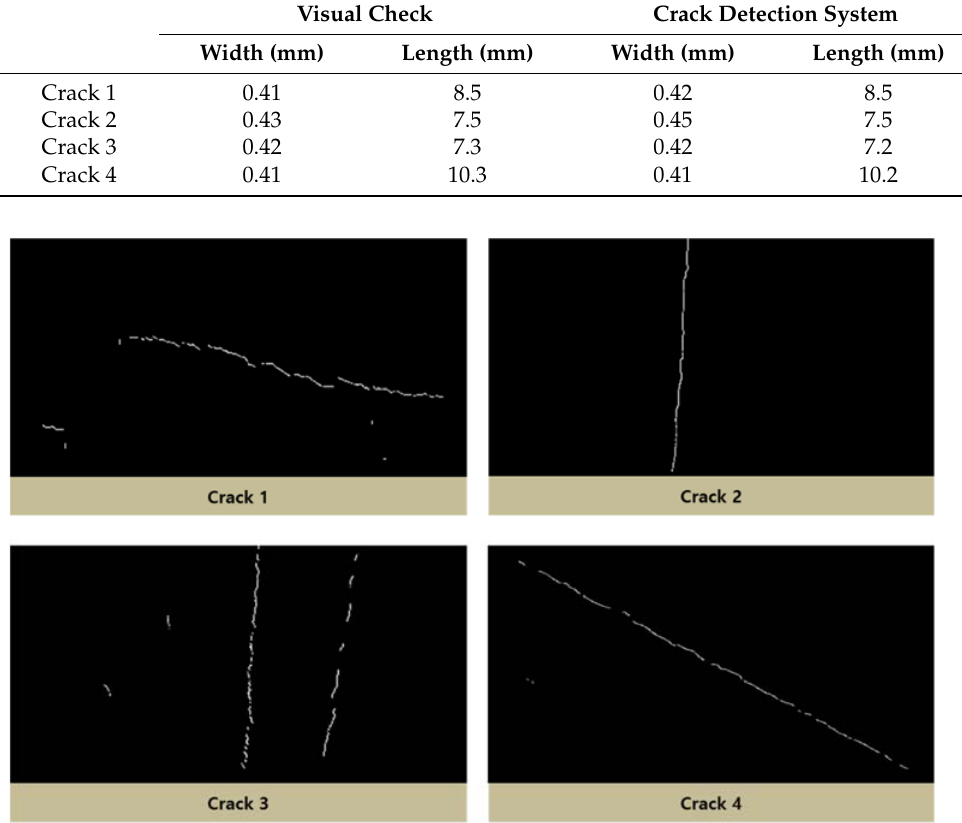
Table 7. Crack size measurement values for visual check and crack detection system.